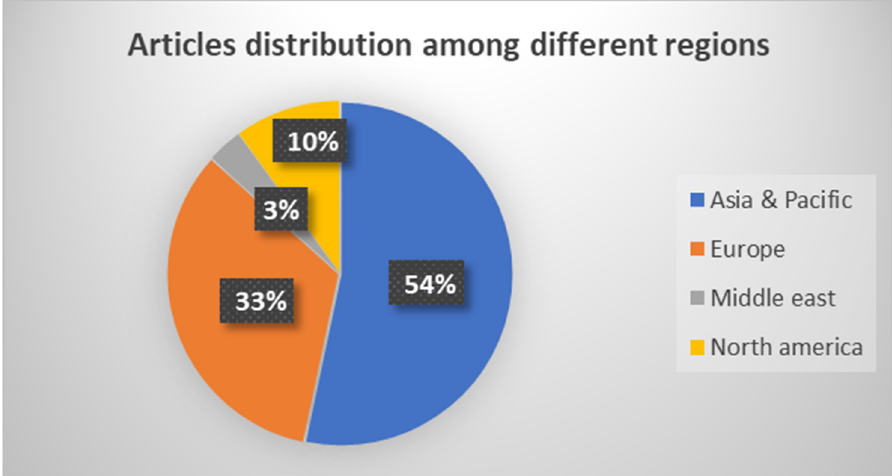
Figure 4. Articles distribution among different regions .